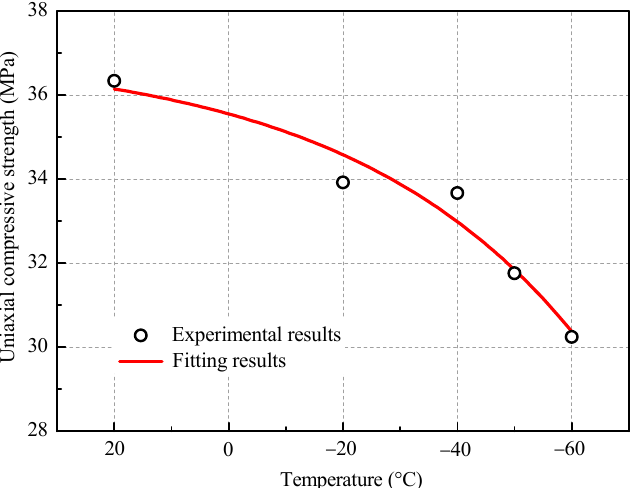
Figure 6. Variation of static uniaxial compressive strength with freezing temperature.